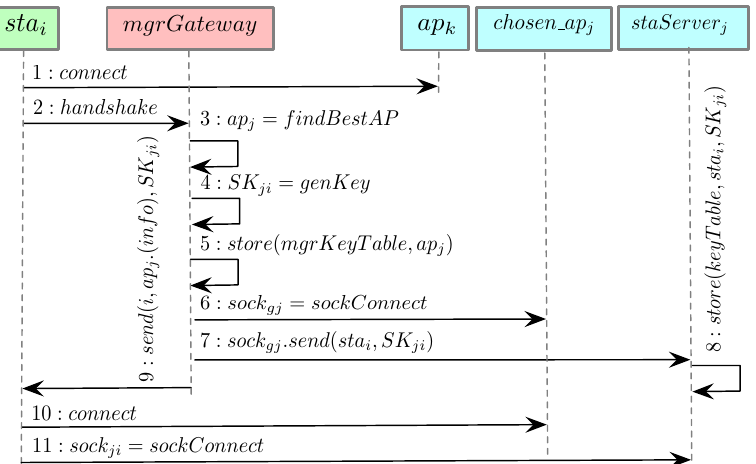
Figure 3. Sequence diagram describing the process of adding a new station to the network. Dur- ing this process, a newly joined station is associated with an optimal AP. Once this process is finished, a station can offload its TLS computation to the associated